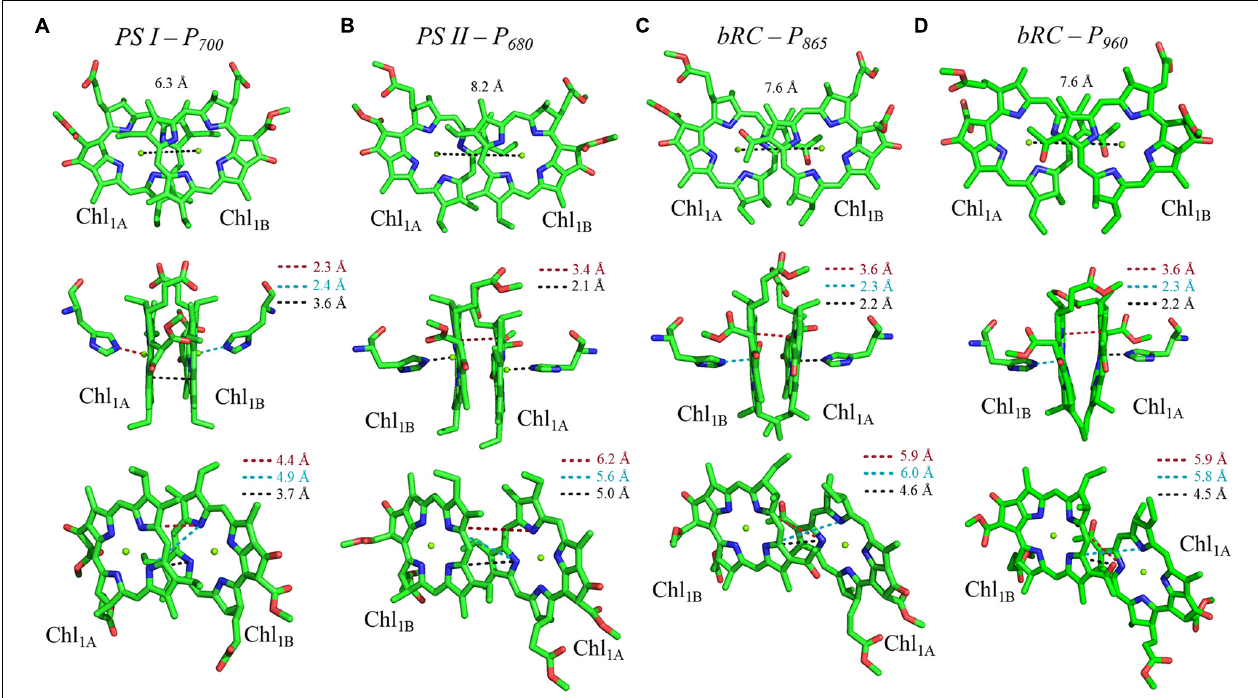
FIGURE 5 | Analysis of inter-cofactor distances and relative orientation of primary donors from the heterodimeric RCs: (A) Photosystem I, (B) Photosystem II, and the bacterial RC from (C) Rba. sphaeroides and (D) Rps. viridis .